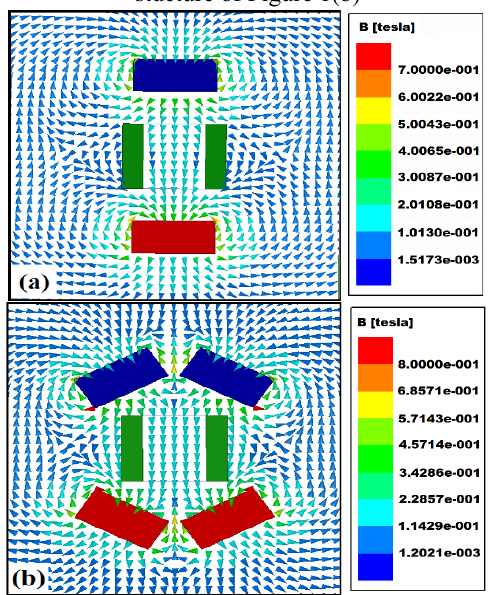
Figure 4: Magnetic flux lines for: (a) augmented railgun with 2 magnets. (b) Augmented railgun with 4 magnets.